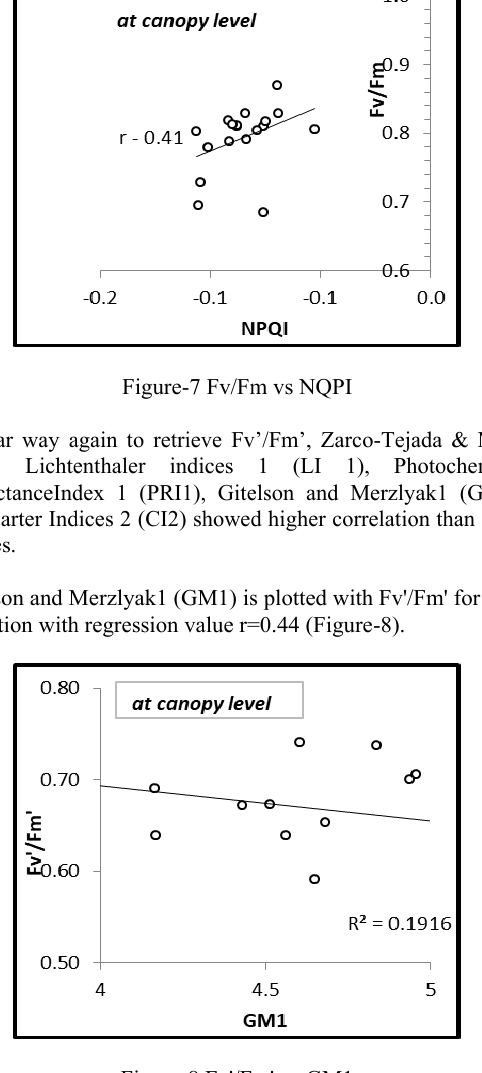
Figure-8 Fv'/Fm' vs GM1